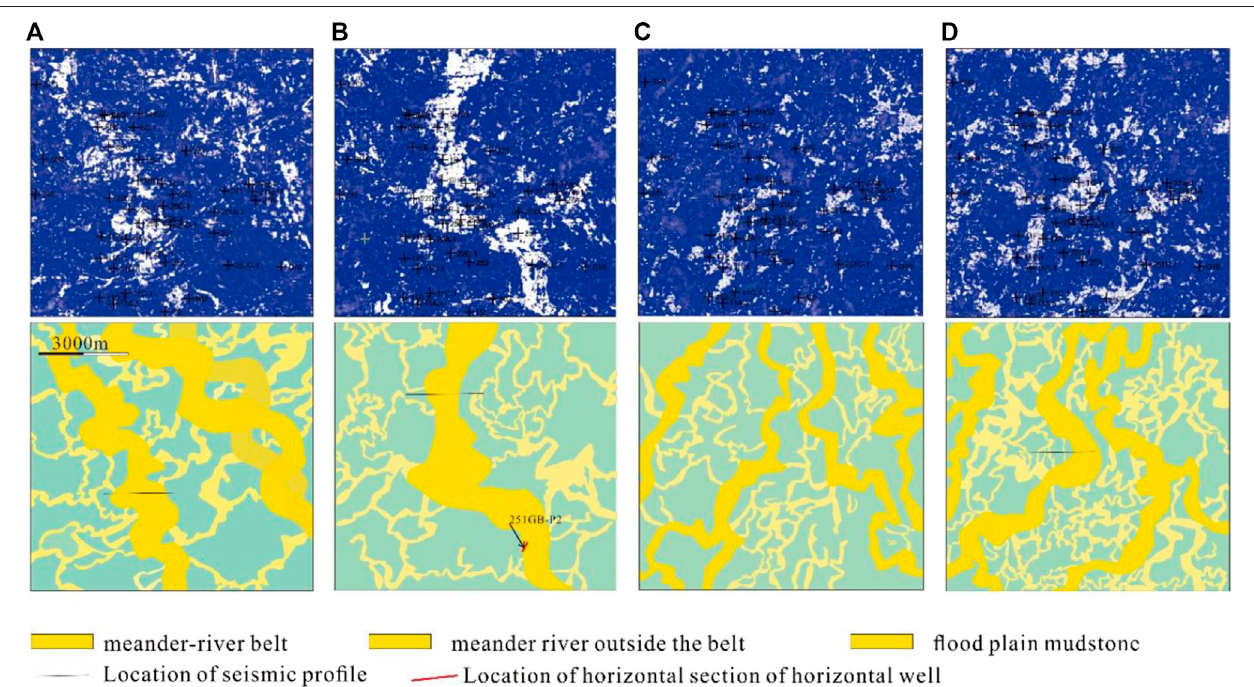
FIGURE 4 | Plane distribution characteristics of fl uvial facies deposits in the main layer of the study area. (A) Plane distribution characteristics of meander-river belt and secondary channel in Ng33 sub-layer. (B) Plane distribution characteristics of meander-river belt and secondary channel in Ng42 sub-layer. (C) Plane distribution characteristics of meander-river belt and secondary channel in the early stage of Ng45 sub-layer. (D) Plane distribution characteristics of meander-river belt and secondary channel in the main stage of Ng45 sub-layer.